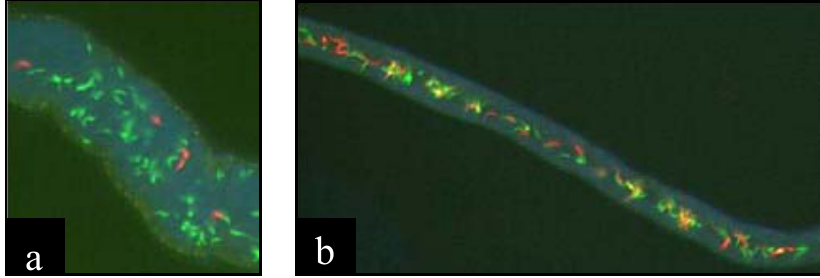
Figure 2. Demonstrating that fluorescence microscopy can identify trypanosome hybrids. Fluorescent proteins indicate the hybrid (yellow) or parental status (red and green) of trypanosome parasites. (a) Close proximity of red and green parental trypanosomes in salivary glands at early establishment. Flies dissected at 20 days. (b) Yellow hybrids with red and green parental trypanosomes in salivary glands. Flies dissected at 27 days. Trypanosomes are 20–30 μ m in length. Reprinted from Gibson et al. [63], originally published by BioMed Central.